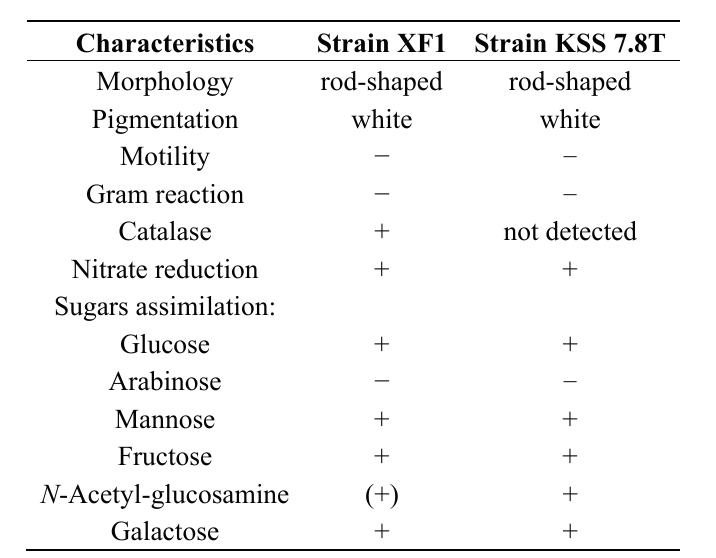
1. Physiological characteristics of Pseudochrobactrum sp. XF1 and Pseudochrobactrum lubricantis KSS